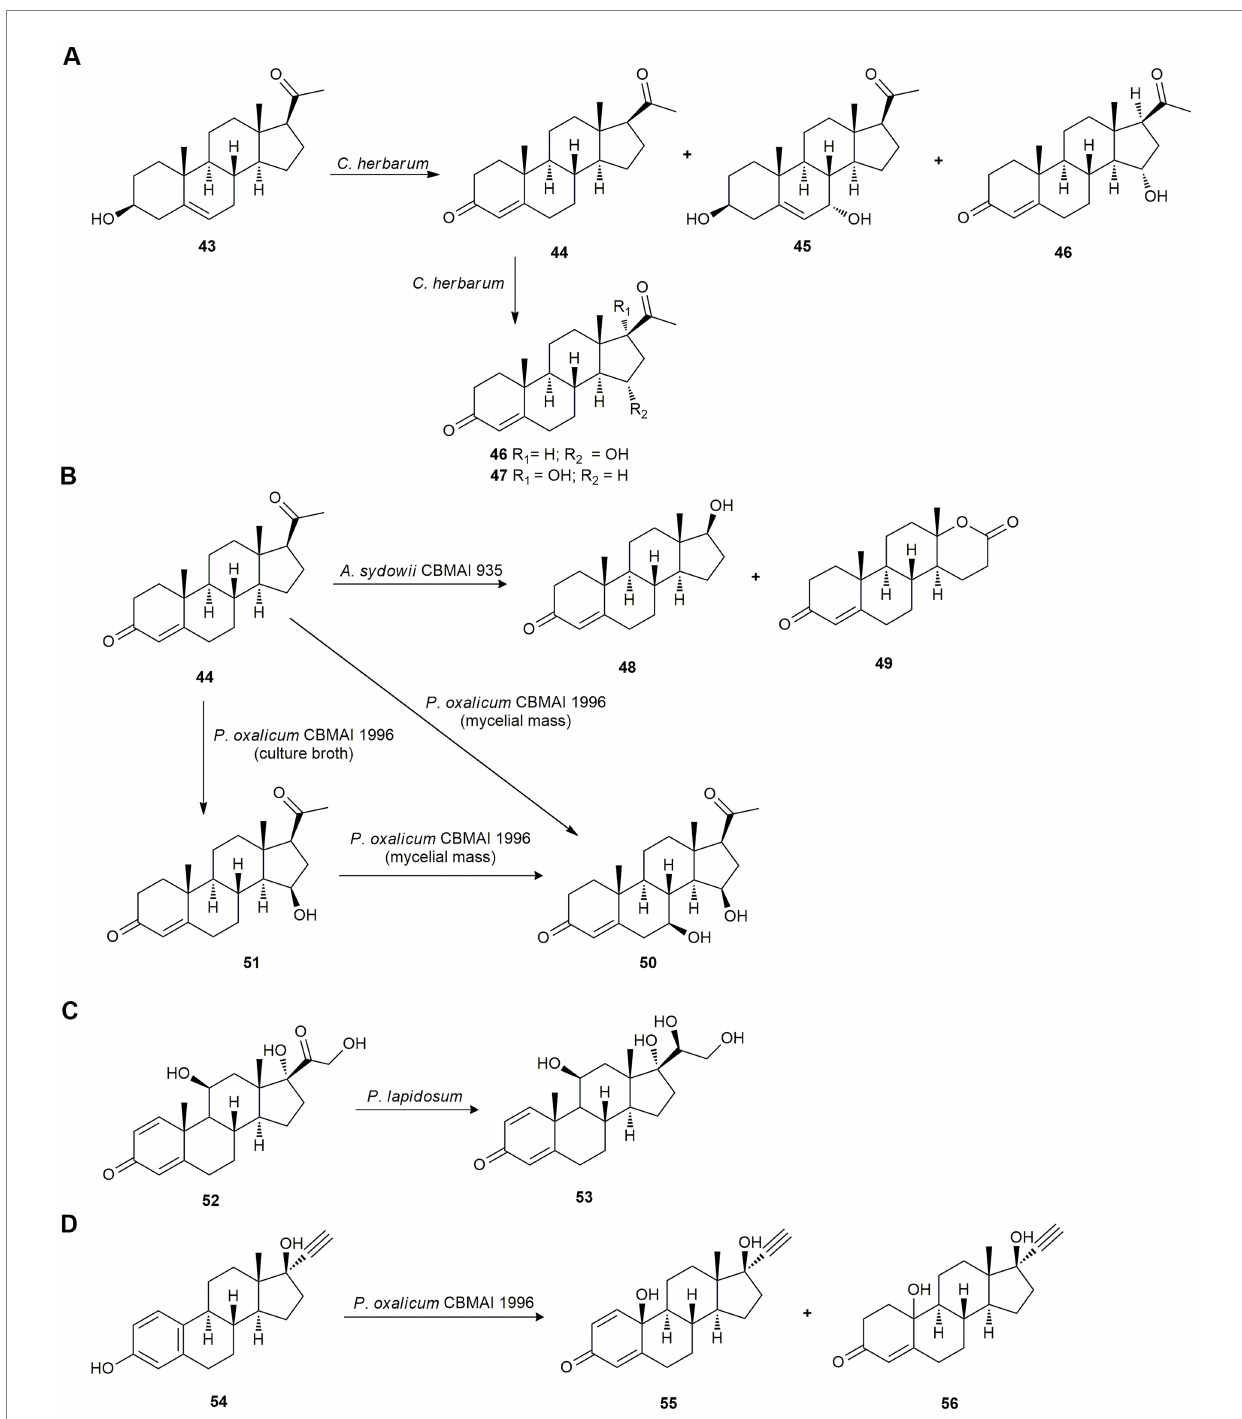
FIGURE 3 Steroid biotransformations. (A) Biotransformation of pregnenolone ( 43 ) and progesterone ( 44 ) by Cladosporium herbarum (Namboori et al., 1980). (B) Biotransformation of progesterone ( 44 ) by Aspergillus sydowii CBMAI 935 (de Paula and Porto, 2020) and by Penicillium oxalicum CBMAI 1996 (de Paula et al., 2021) (C) Prednisolone ( 52 ) reduction by Penicillium lapidosum SSW (Sultan et al., 2014). (D) Ehinylestradiol ( 54 ) bioconversion by P. oxalicum CBMAI 1996 (de Queiroz et al.,